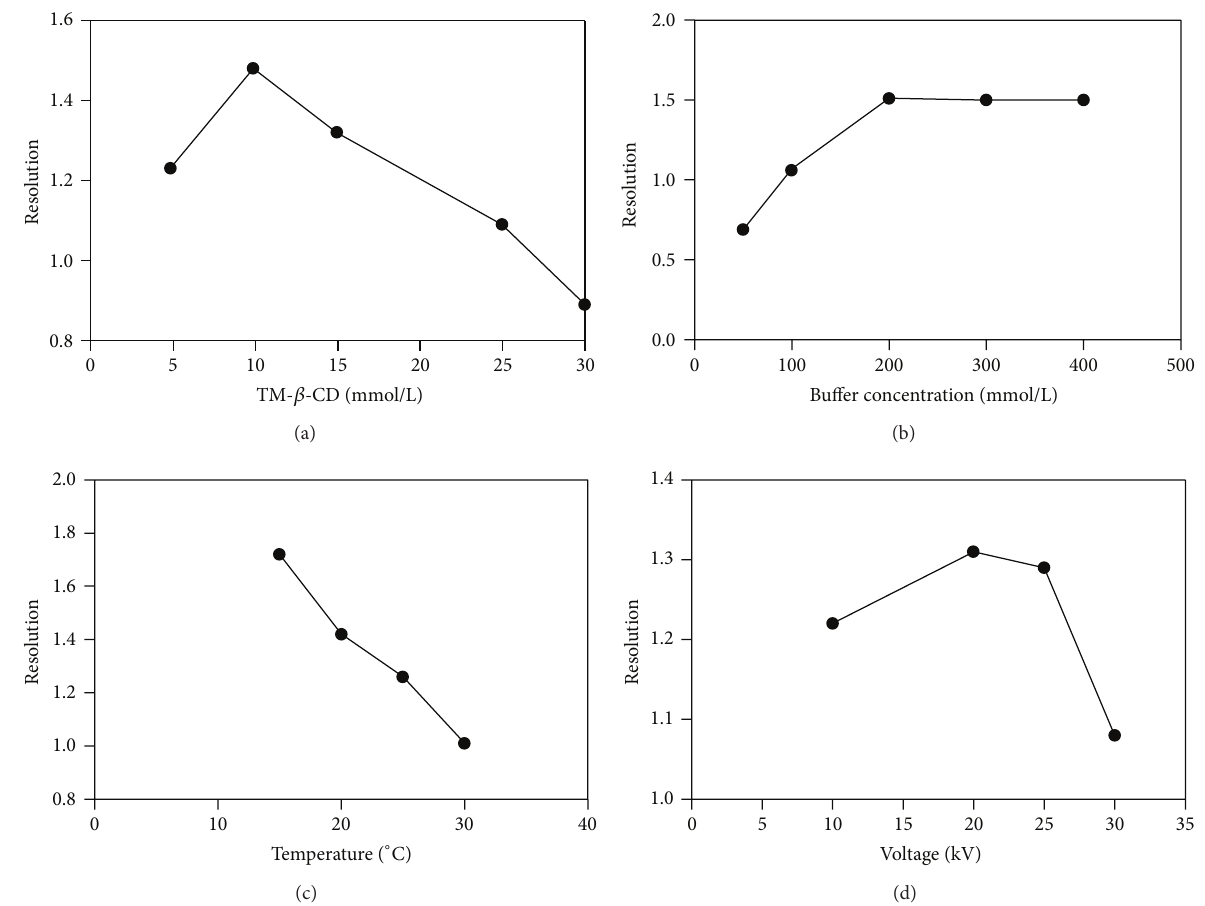
Figure 2: Effect of (a) TM- 𝛽 -CD concentration (mmol/L); (b) buffer concentration (mmol/L); (c) temperature ( ∘ C) and (d) voltage (kV) on the resolution of LER enantiomers. Experimental conditions: fused-silica uncoated capillary 50 𝜇 m id, 60.2 cm in total length and 50.0 cm in effective length, sodium acetate buffer pH 4.0, and 15 ∘ C, 25 kV, 237 nm, and injection: 10 seconds (at a pressure of 0.5 psi). Other conditions were changed according to each